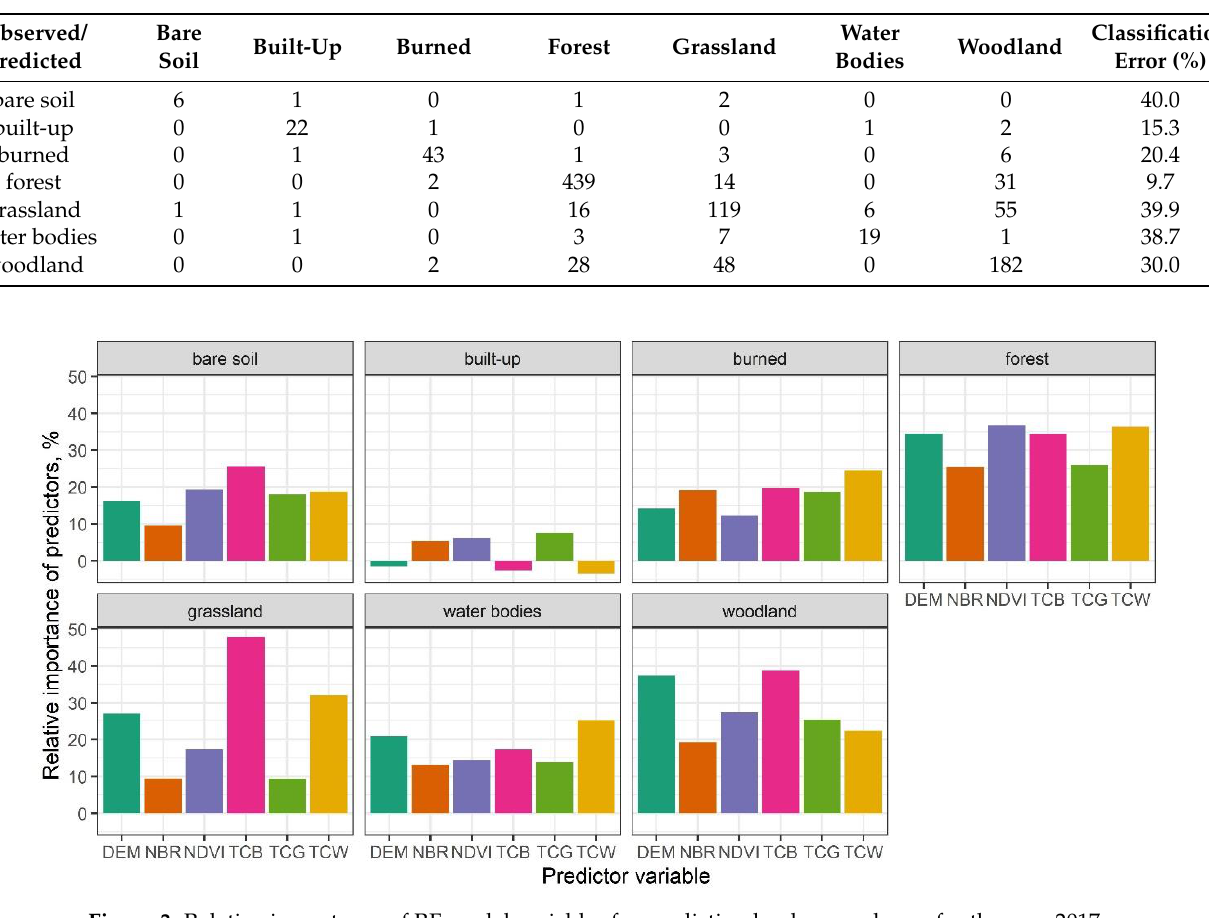
Figure 3. Relative importance of RF model variables for predicting land cover classes for the year 2017.